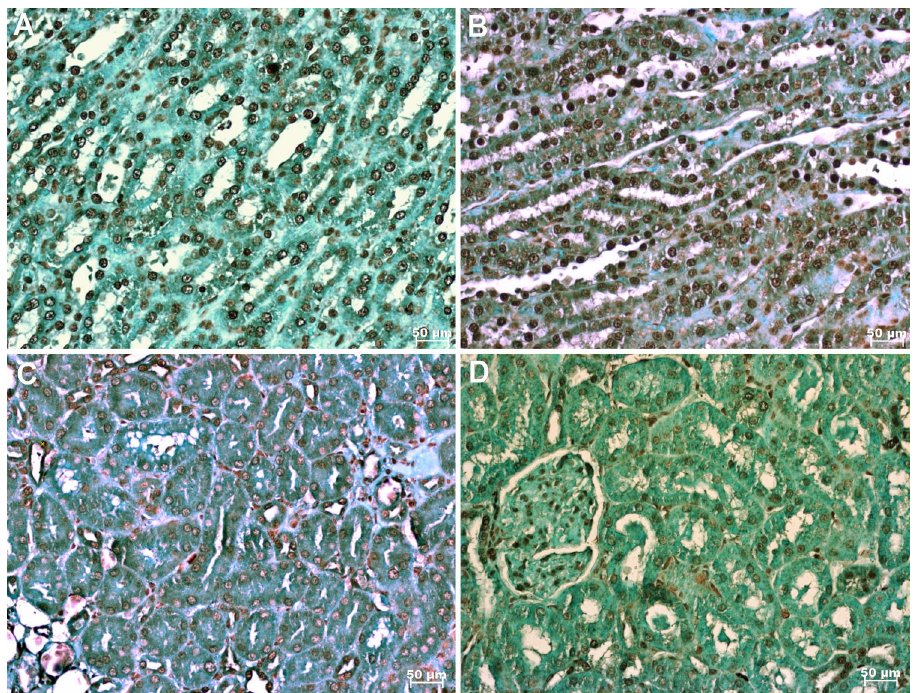
Figure 2 - Photomicrography showing apoptosis in the kidney labeled by immunohistochemical staining (TUNEL; x 200). A. no resuscitation group (IO-intestinal obstruction and ischemia) B. Ringer ’ s lactate group (RL) C. Ringer ’ s lactate + pentoxifylline group (RL + PTX) D. Hypertonic saline + pentoxifylline group (HS +